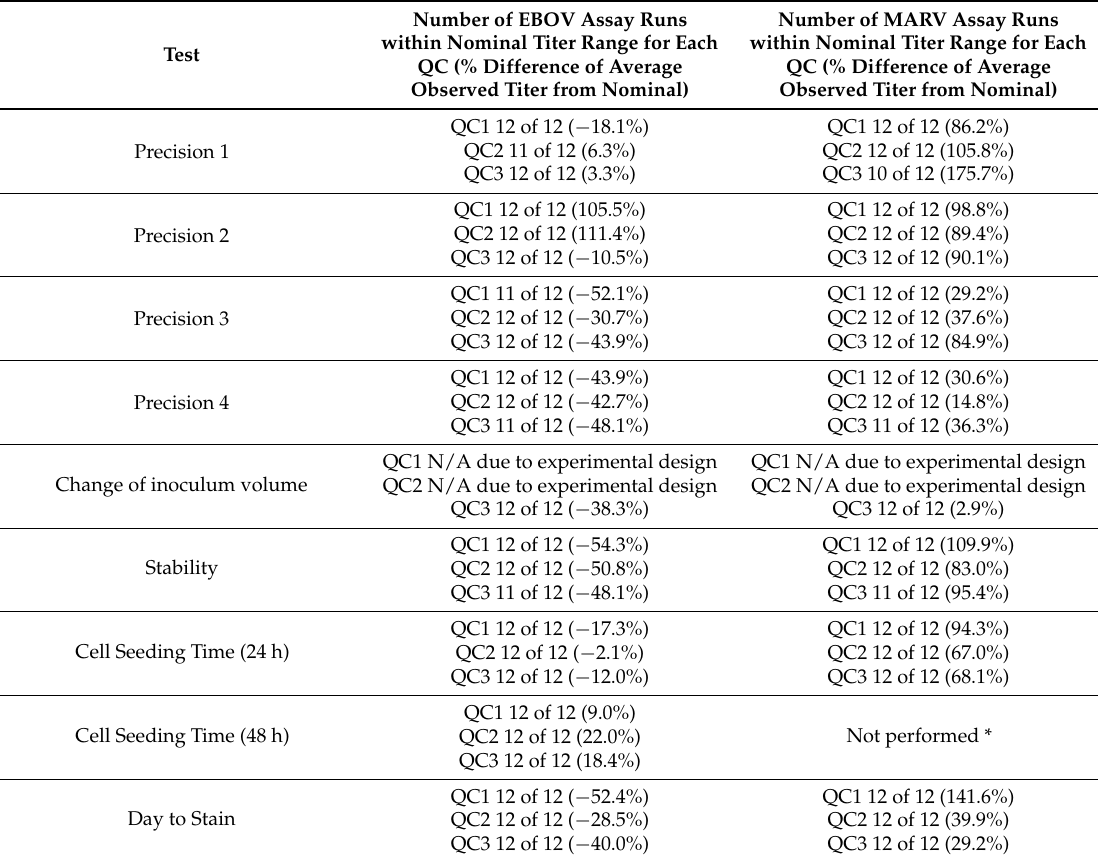
Table 3. Tests on the validation, which were of a similar design to the accuracy tests and passed the accuracy